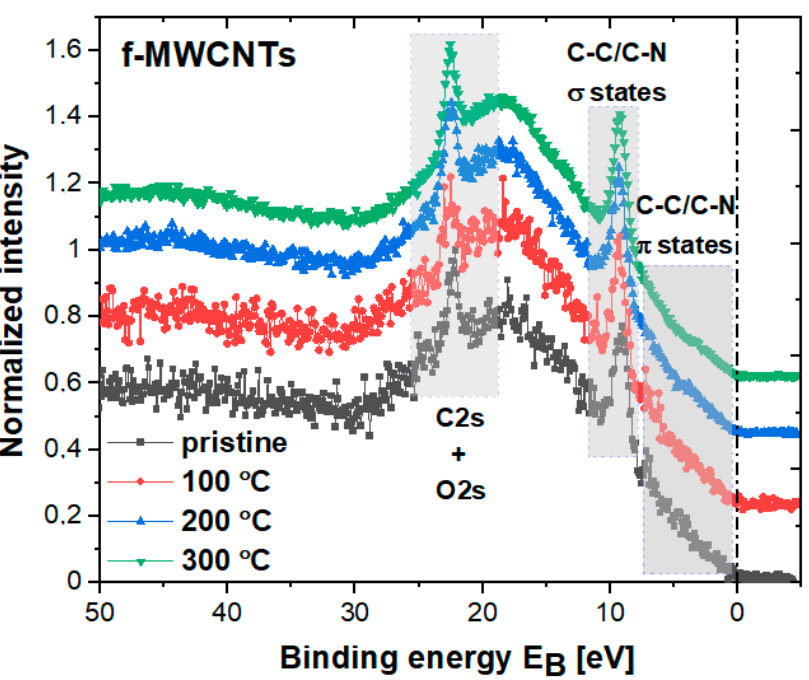
Figure 4. The comparison between valence bands in pristine and calcined f-MWCNTs samples.